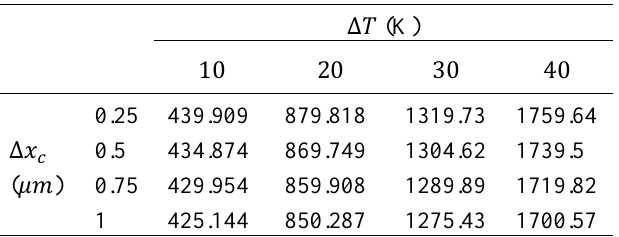
Table 2 defines the numerical values for heat flux.